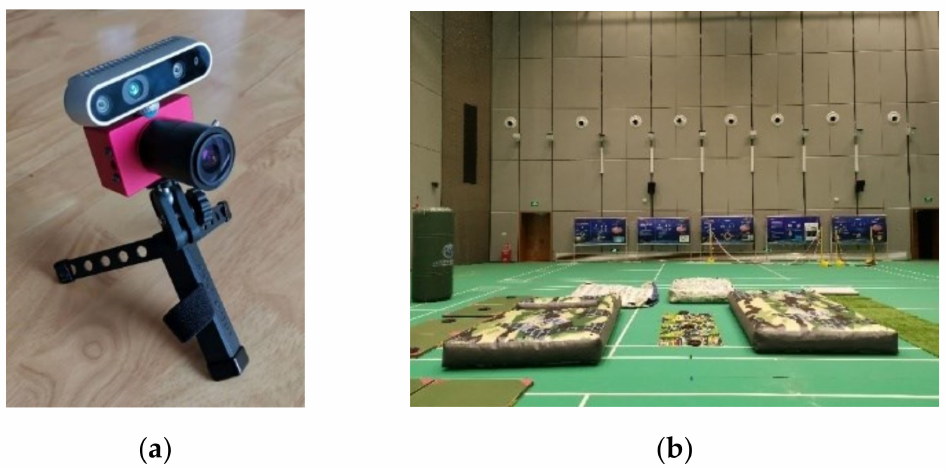
Figure 9. Equipment and scenarios for handheld experiments: ( a ) the handheld device; ( b ) the environment in the hall.